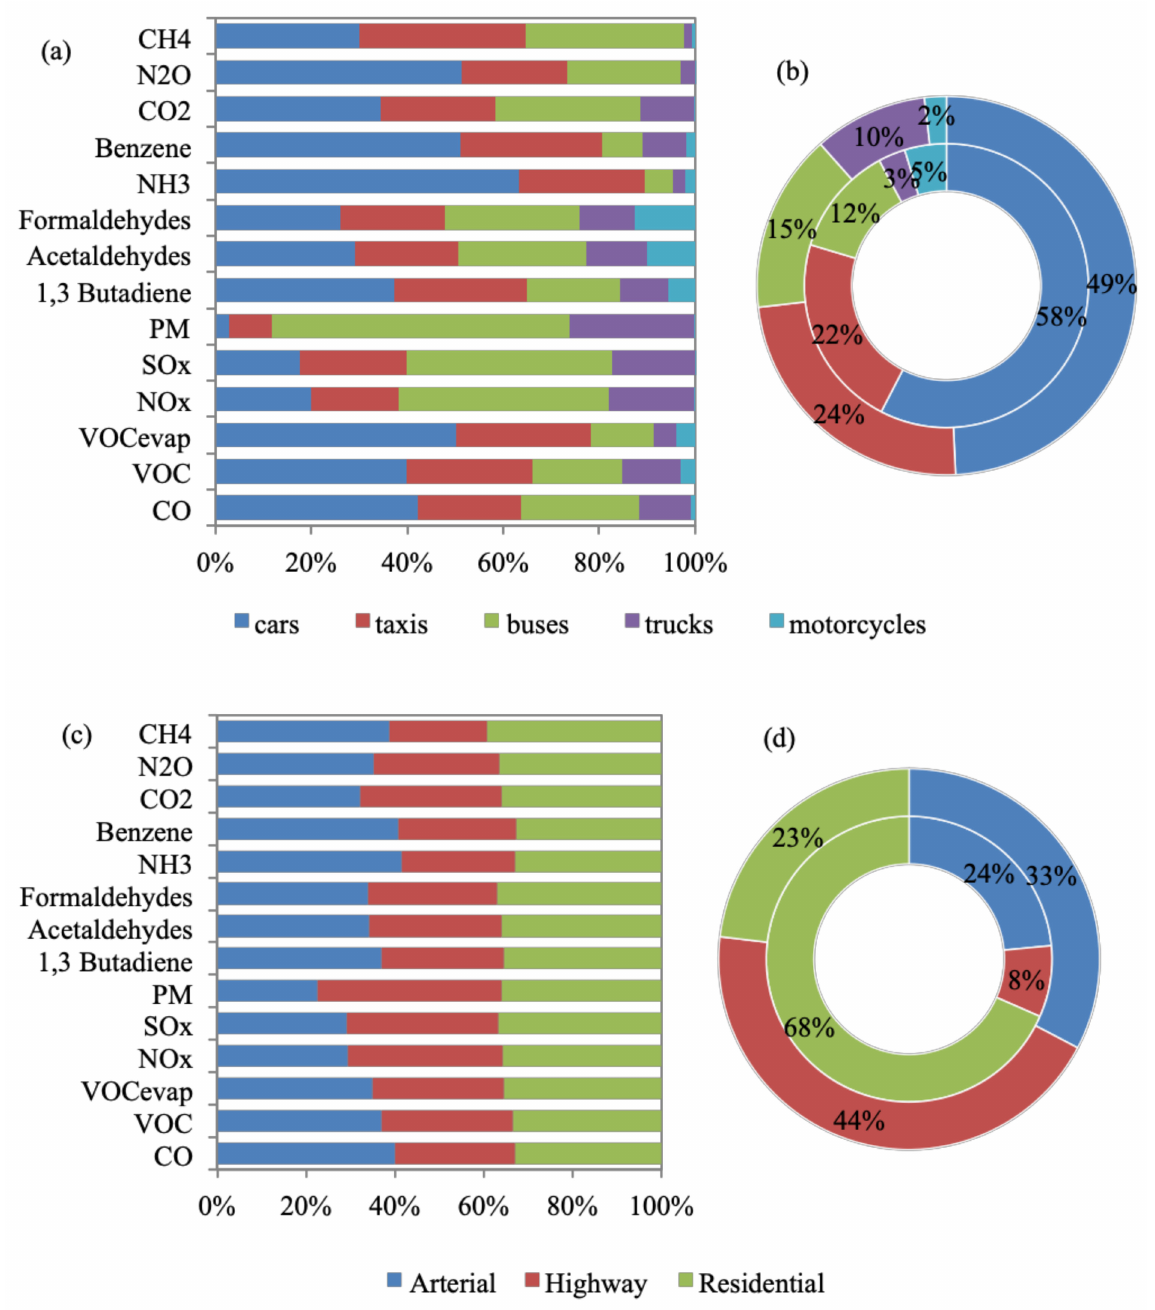
Figure 3. Vehicle type ( a , b ) and road type ( c , d ) percentage distributions according to ( a , c ) 2019 emissions’ quantities; ( b , d ) outer donut is VKT and inner donut is number of